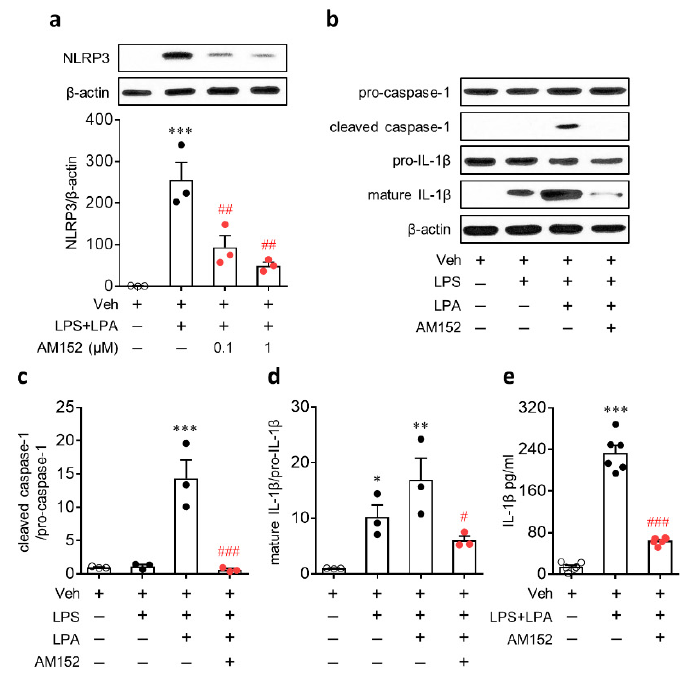
Figure 5. LPA 1 antagonist attenuates LPA-induced NLRP3 inflammasome activation in lipopolysaccharide (LPS)-primed bone marrow-derived macrophages (BMDMs). Cells were primed with LPS (500 ng / mL) for 4 h, followed by an exposure to LPA (1 µ M) for 1 h. ( a – d ) Protein expression levels of NLRP3, pro-caspase-1, cleaved caspase-1, pro-IL-1 β , and mature IL-1 β determined by Western blot analysis. ( a ) NLRP3 expression determined by Western blot analysis. AM152 was treated at di ff erent concentration (0; 0.1 and 1 µ M). n = 3 per group. *** p < 0.001 versus control BMDMs (Veh). ## , p < 0.01 versus stimulated BMDMs (LPS-primed BMDMs, followed by an exposure to LPA; LPS + LPA). ( b – d ) Caspase-1 activation and IL-1 β maturation determined by Western blot analysis. AM152 was treated at 1 µ M. Representative Western blots of pro-caspase-1, cleaved caspase-1, pro-IL-1 β , and mature IL-1 β ( b ) and quantification of caspase-1 activation ( c ) and IL-1 β maturation ( d ) are shown. n = 3 per group. * p < 0.05, ** p < 0.01, and *** p < 0.001 versus control BMDMs (Veh). # p < 0.05 and ### p < 0.001 versus stimulated BMDMs (LPS-primed BMDMs, followed by an exposure to LPA; LPS + LPA). ( e ) Amounts of secreted IL-1 β into the culture medium were measured by enzyme-linked immunosorbent assay (ELISA) analysis. n = 6 per group. *** p < 0.001 versus control BMDMs (Veh). ### p < 0.001 versus stimulated BMDMs (LPS + LPA).